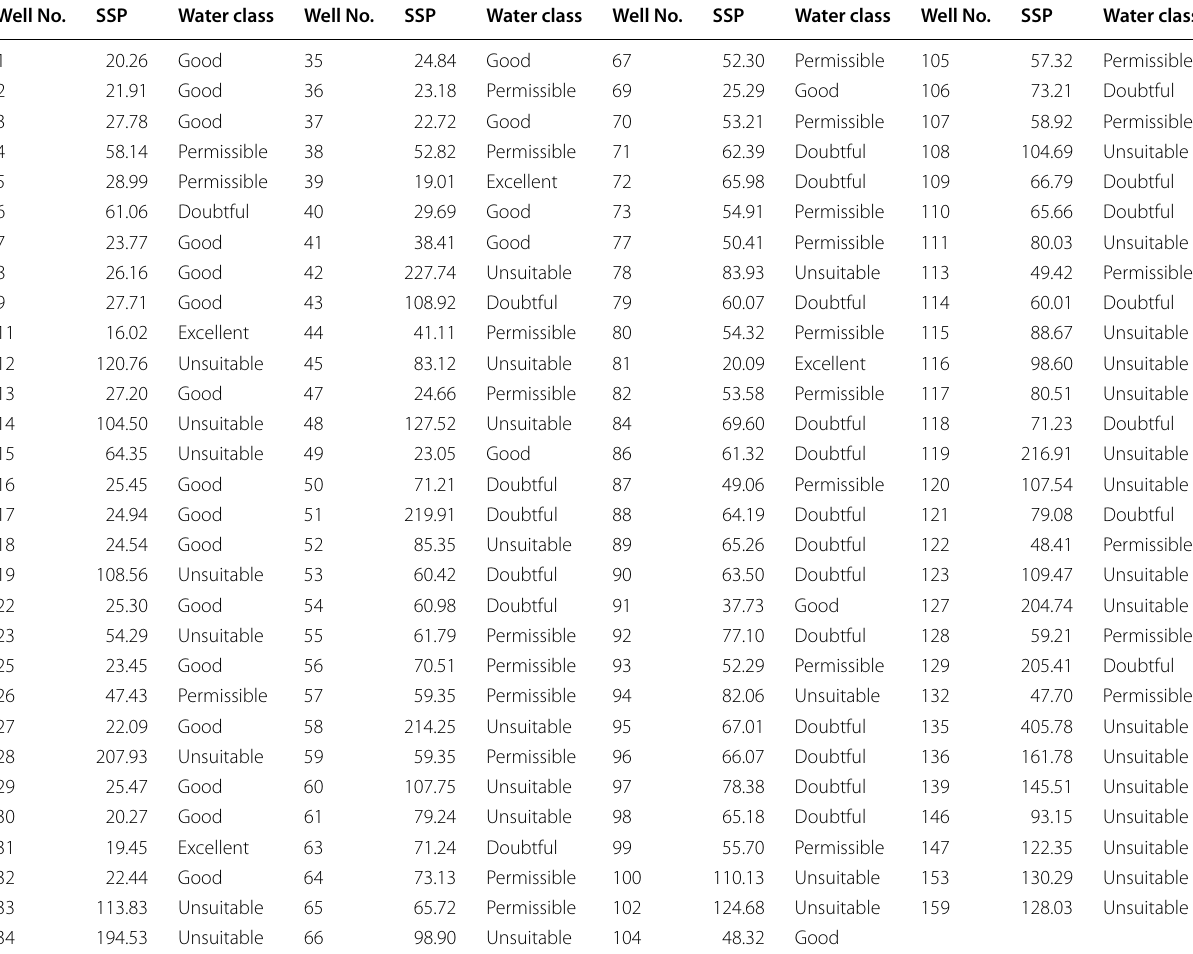
Table 13 Evaluation of groundwater samples for irrigation uses according to SSP Well No.